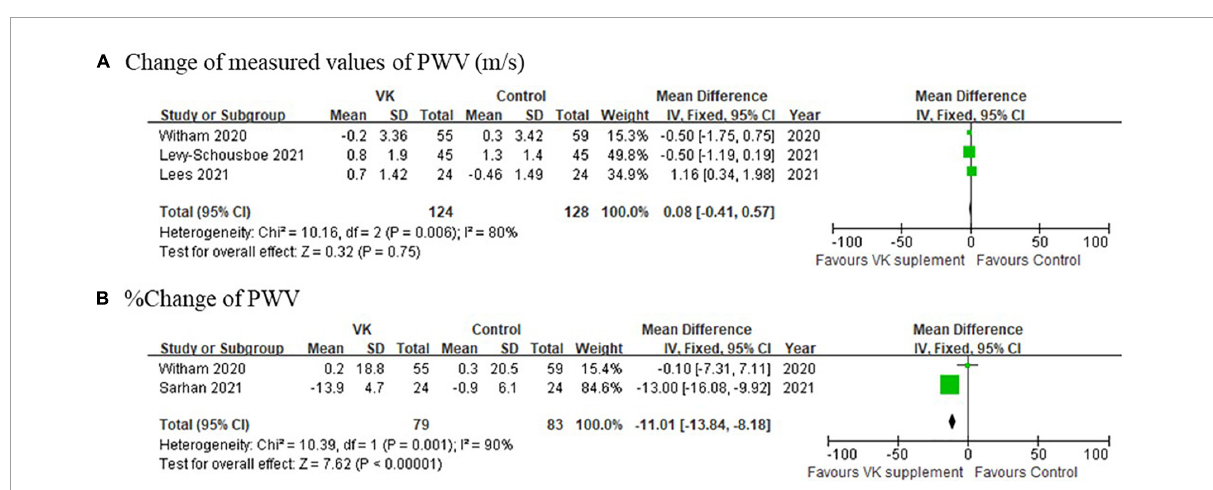
FIGURE5 Pooled changes of pulse wave velocity after Vitamin K supplementation compared with baseline. (A) Absolute and (B) relative change of PWV after Vitamin K supplementation compared with